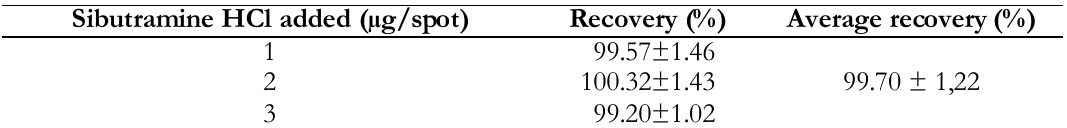
Tabel II. Recovery Study (Accuracy)